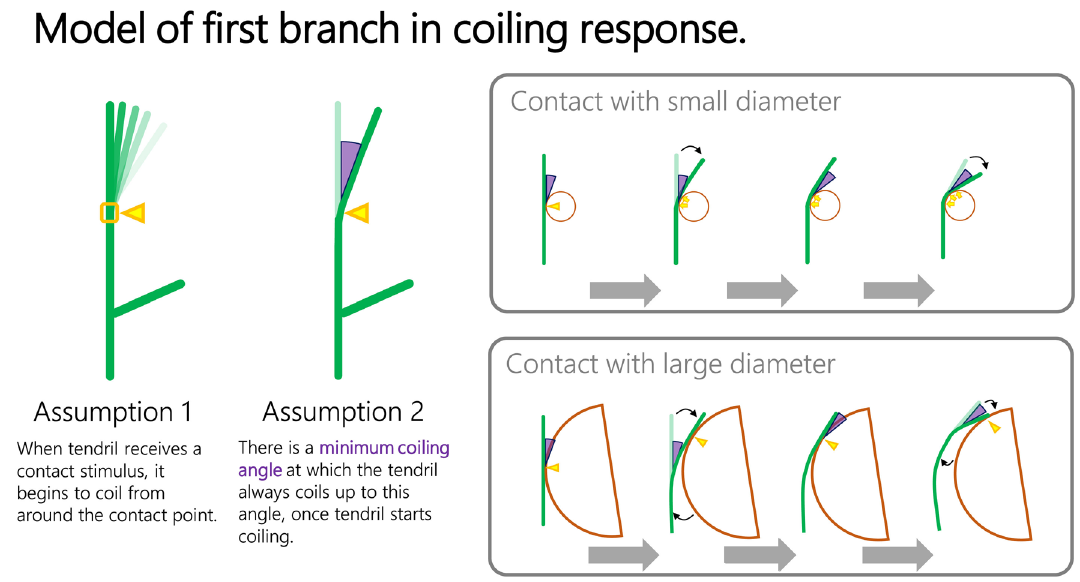
Figure 3. Model that causes the initial phase of coiling response. Two illustrations on the left represents the rules of coiling movement assumed in the model. The green line represents the shape of the tendrils and the yellow triangles represents the contact points between the tendrils and the supports. The purple triangle means the minimum coiling angle of the tendrils. Top and bottom right figures illustrate the expected coiling response when the tendrils are in contact with a support of small and large diameter, respectively.